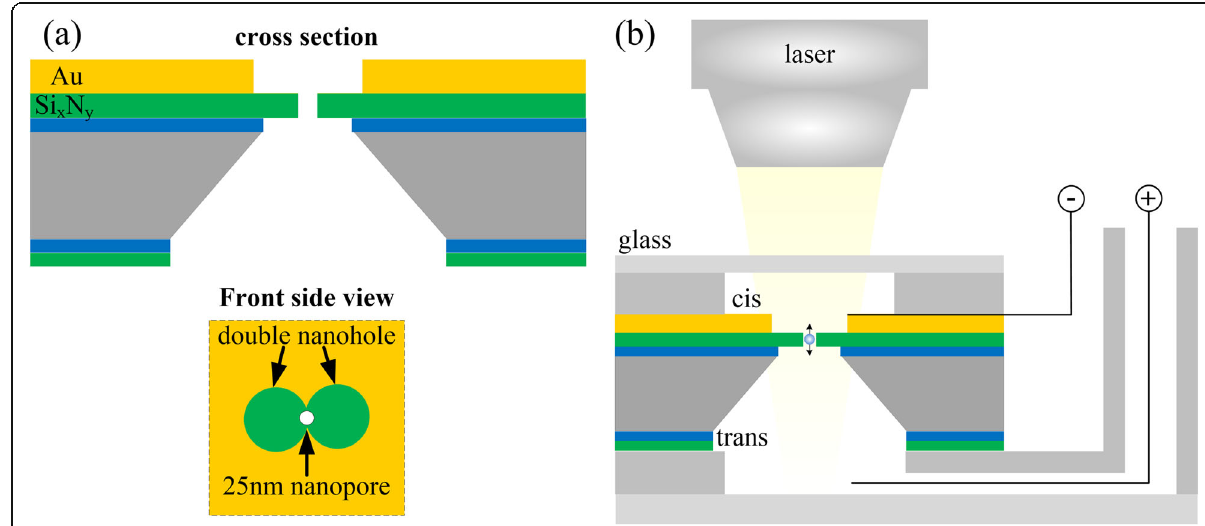
Fig. 3 a Schematic of the Optical trap nanopore chip [47]. b Schematic of the self-induced back-action